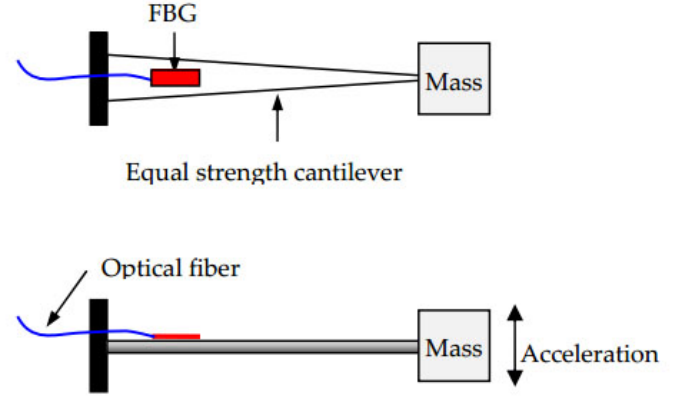
Figure 12. Structural schematic diagram of the designed fiber Bragg grating (FBG) sensor [152] .